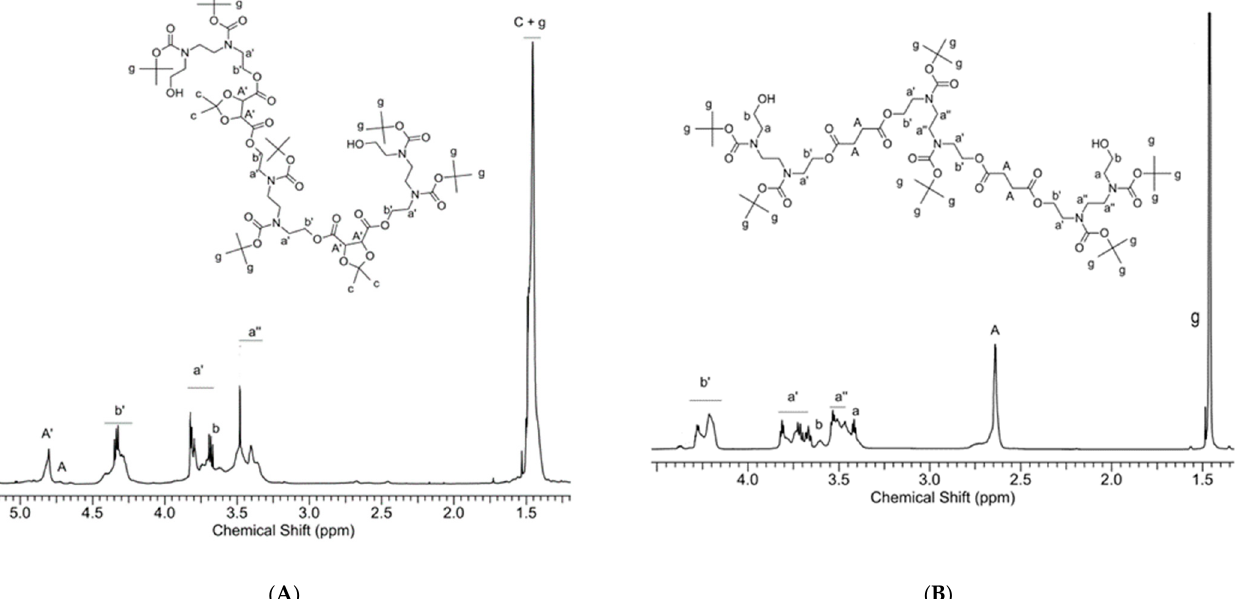
Figure 2. 1 HNMRspectrumof; ( A )poly{(di-tert-butylethane-1,2-diylbis[(2-hydroxyethyl)carbamate]2,3-O- isopropylidene-l-tartrate)}(Table1., I3); ( B )poly{(di-tert-butylethane-1,2-diylbis[(2-hydroxyethyl)carbamate] succinate)} (Table 1,